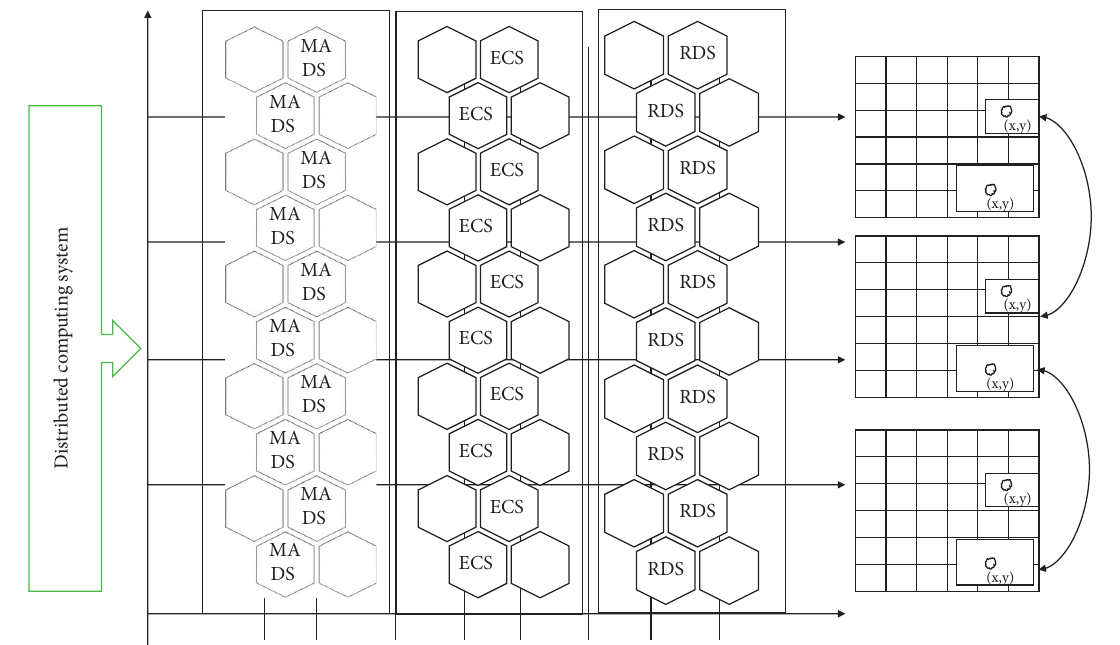
Figure 2: Comprehensive output process of cloud computing